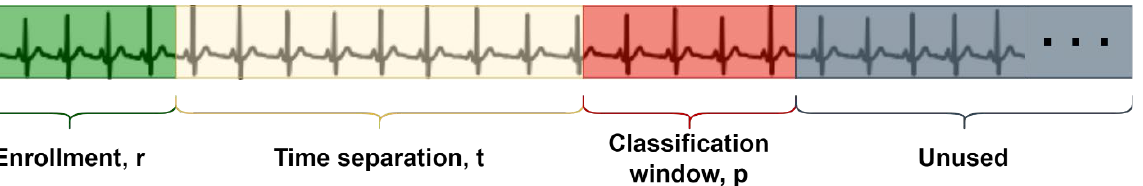
Figure 7. A long ECG recording is divided into enrollment, time separation, and classification win- dow.